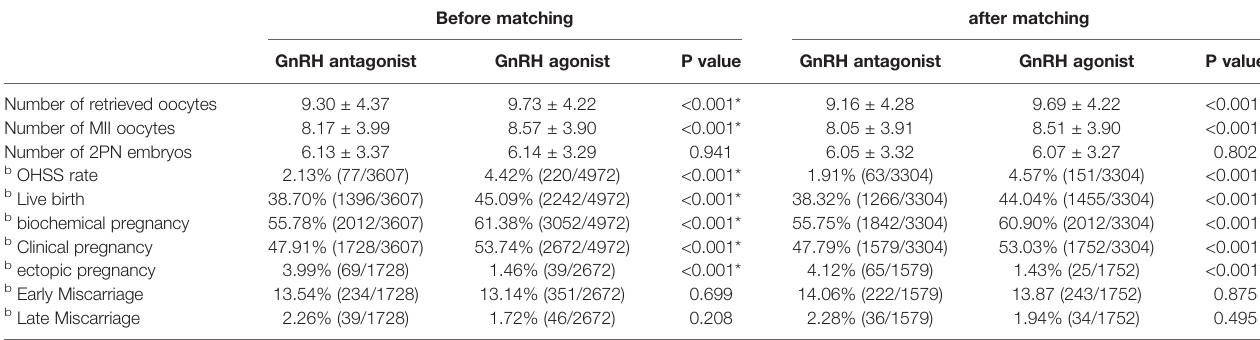
TABLE 2 | Comparison of clinical outcomes between the GnRH agonist long-acting protocol and GnRH antagonist protocol and after PS matching. Before matching after matching GnRH antagonist GnRH agonist P value GnRH antagonist GnRH agonist P value Number of retrieved